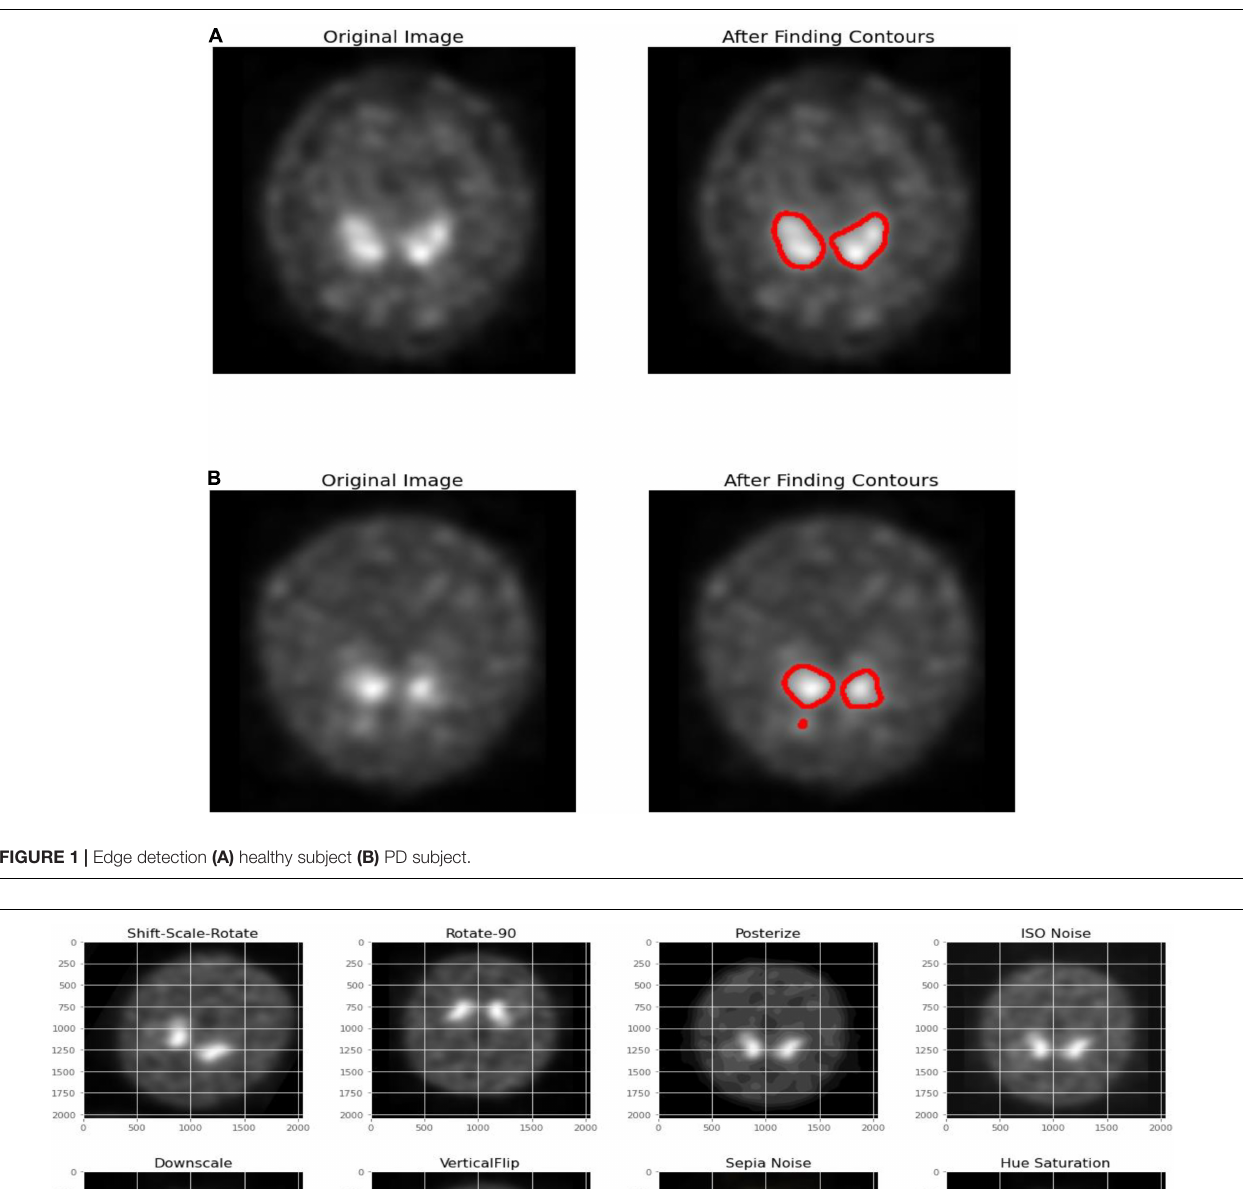
FIGURE 2 | Data augmentation for healthy control